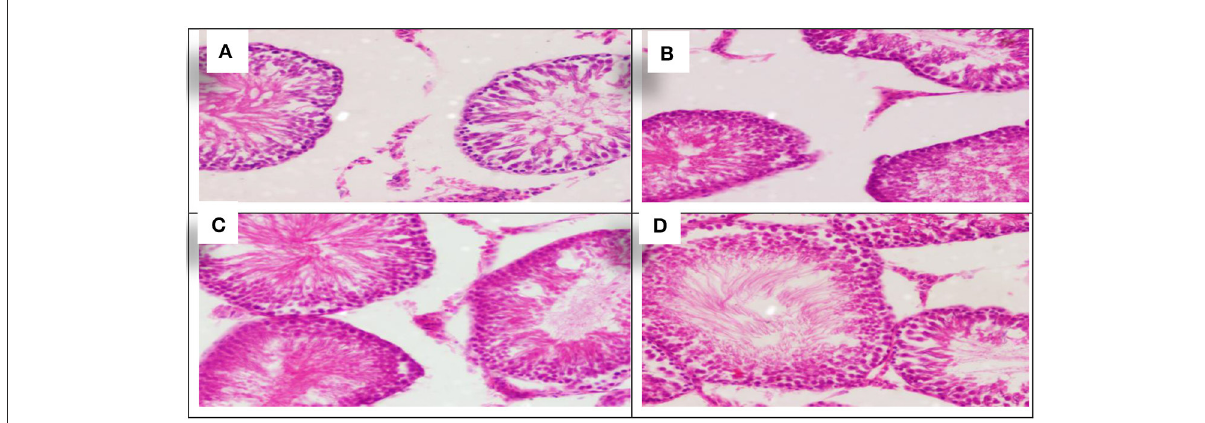
FIGURE7 Schematic diagram showing the effect of each aluminum, medicinal plant, and mix with aluminum and medicinal plants on histopathology of rats’ testicular tissues during return to normal after exposure to aluminum toxicity at 60 days after treatment. (A) Control group. (B) Allium sativum 5%. (C) Nigella sativa 5%, and (D) Allium sativum 2.5% + Nigella sativa